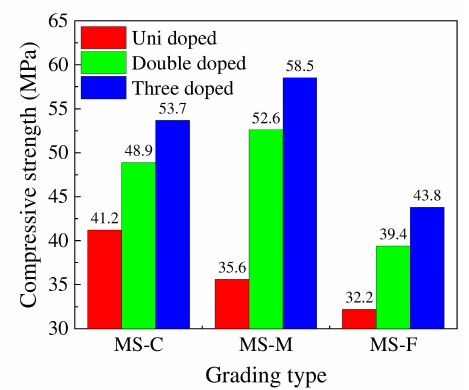
Figure 8. Influence of gradation on the HPC compressive strength at 90